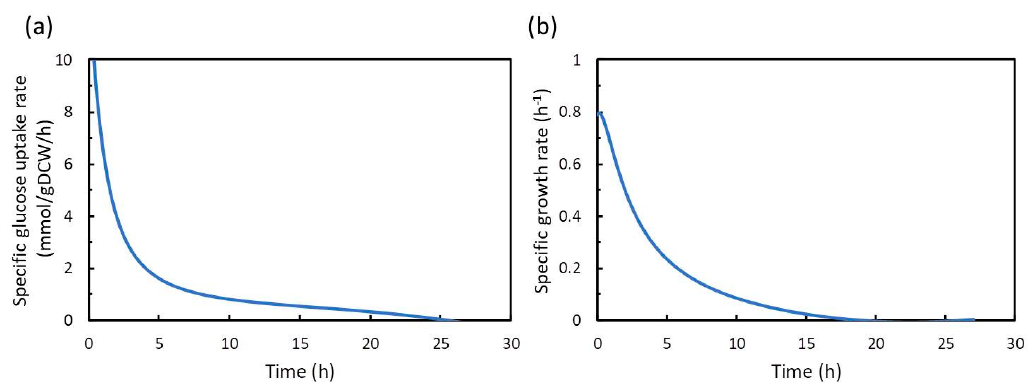
Figure 3. Time-course data of the approximated specific glucose uptake rate ( a ) and the approximated specific growth rate of cells (biomass) ( b ) estimated from the approximate formula.